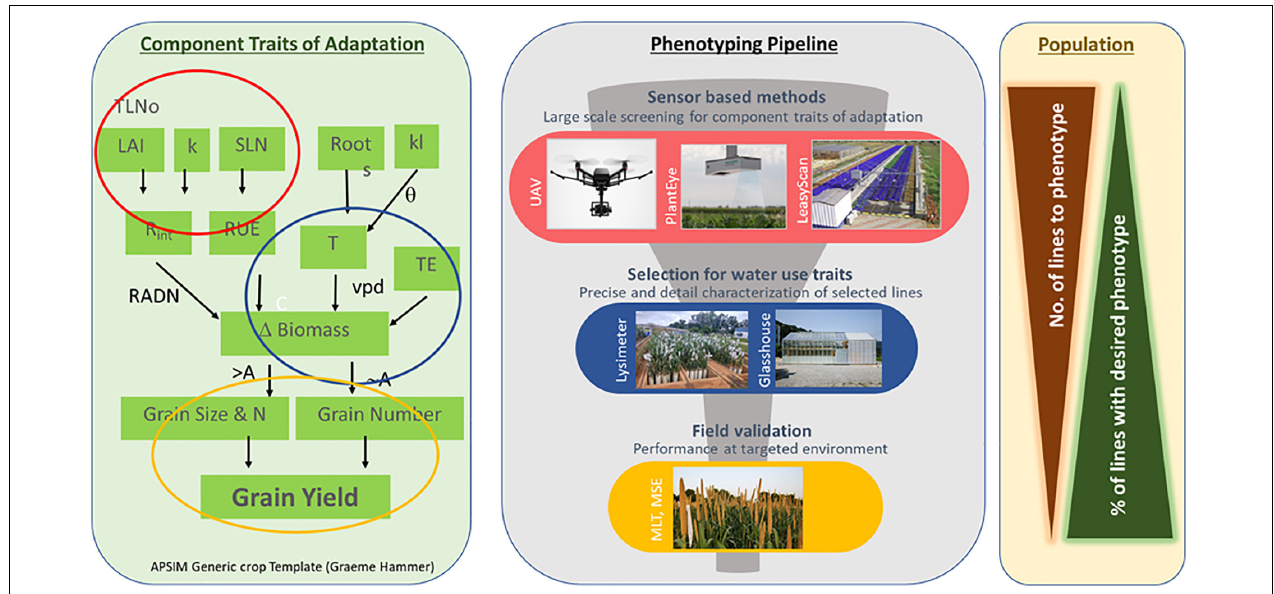
FIGURE 4 | Phenotyping principle supporting drought breeding programs.LAI, leaf area index; TL No, tiller number; SLN, specific leaf nitrogen; Rint, radiation intercept; RUE, radiation use efficiency; RADN, radiation; kl, crop rooting parameters; T, transpiration; TE, transpiration efficiency; –VPD, vapor pressure deficit; Grain N, grain s; A, assimilation; UAV, unmanned aerial vehicle; MLT, multilocation testing; MSE, multisite